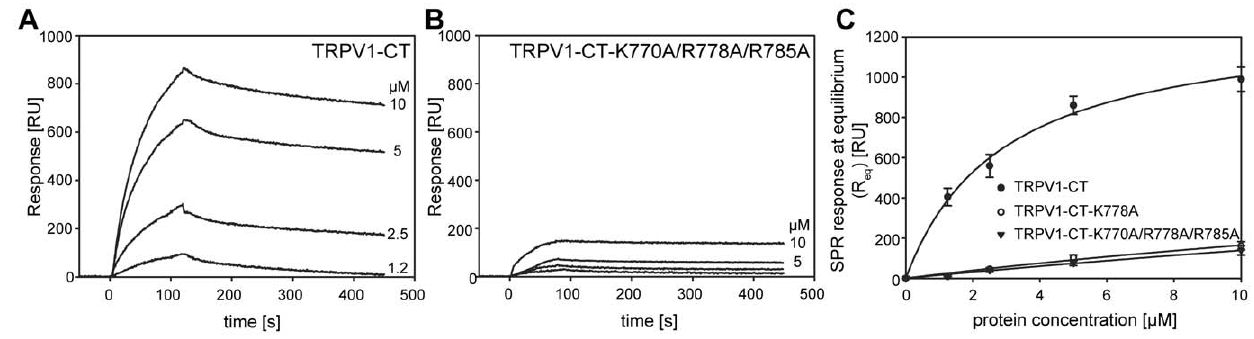
Figure 2. Surface plasmon resonance (SPR) analysis of interactions between TRPV1-CT and PIP2-enriched liposomes. Kinetic binding measurements of TRPV1-CT (A) and the TRPV1-CT-K770A/R778A/R785A triple mutant (B) to the sensor chip coated with PC/PIP2 (80:20) liposomes. The proteins at indicated concentrations were injected in parallel over the lipid vesicles and the flow rate was maintained at 30 m l/min for both association and dissociation phases of the sensograms. (C) SPR equilibrium binding of the TRPV1-CT, TRPV1-CT-K770A/R778A/R785A, and TRPV1-CT- R778A proteins to the sensor chip coated with PC/PIP2 (80:20) liposomes. The proteins were injected at 25 m l/min at different concentrations and washed over the lipid surface and Req values were deduced from steady state (equilibrium) SPR response. The solid lines represent binding isotherms determined by nonlinear least-squares analysis of the isotherm using an equation Req=Rmax/1 + Kd/P0), where Req stands for SPR response value near -equilibrium, Rmax is the maximum response and P0 is the protein concentration. Values represent the mean 6 S.D from four independent experiments.